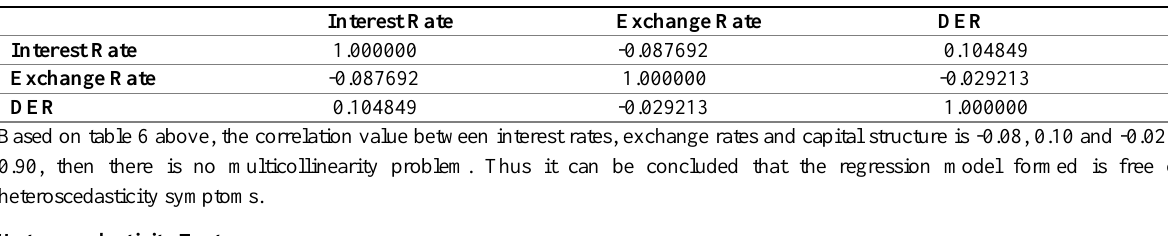
Table 6: Multicollinearity Test